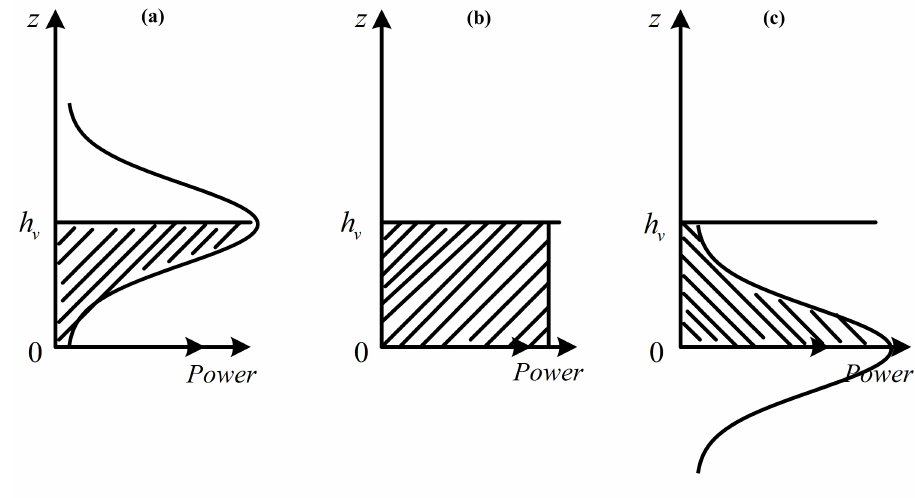
Figure 4. The profile of two-dimensional Gaussian vertical backscatter volume over ground. ( a ): δ = h v ; ( b ): constant volume profile; ( c ): δ =